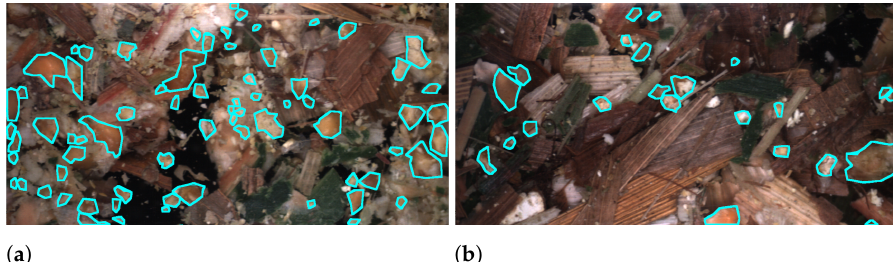
Figure 2. The difference in kernel fragmentation potentially present in images between different PGs. Both samples are harvested with TLOC of 11.5 mm but ( a ) had a PG of 1 mm and ( b ) 4 mm.